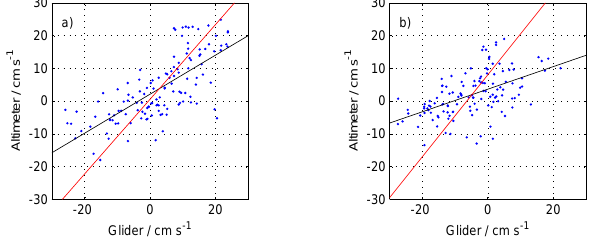
Figure 11. Scatter plot of glider vs. altimeter speeds; (a) east, (b) north. Correlation lines (cms − 1 ) are fitted to Aviso (black) and to the glider (red), and correspond to values in Table 2. Altimeter values have been interpolated in time and space to coincide with the glider observations.